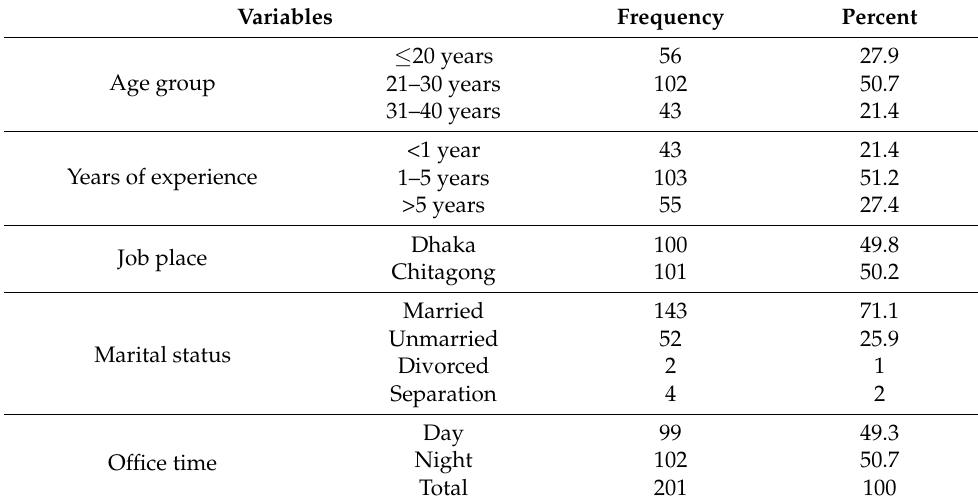
Table 1. Summary of demographic information [ n = 201].